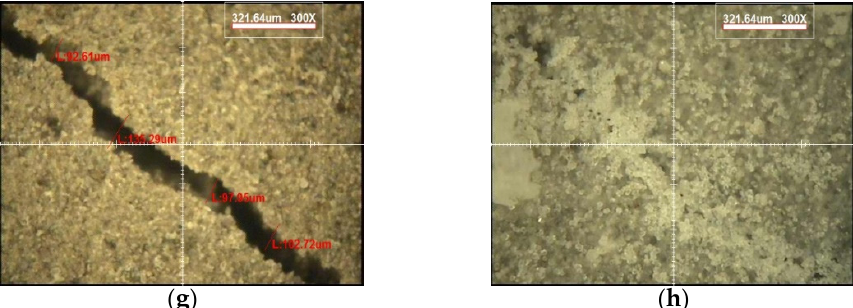
Figure 12. Results of observation of crack: ( a ) plain (initial crack) ( b ) plain (crack healing), ( c ) SHC 10%—850 μ m (initial crack) ( d ) SHC 10%—850 μ m (crack healing), ( e ) SHC 10%—600 μ m (initial crack) ( f ) SHC 10%—600 μ m, (crack healing), ( g ) SHC 10%—300 μ m (initial crack), ( h ) SHC 10%—300 μ m (crack healing).